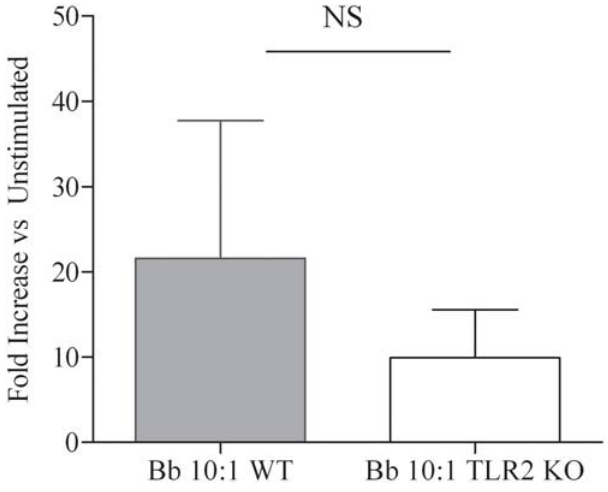
Figure 8. Wild type (WT) and TLR2 deficient bone marrow derived macrophages (BMDMs) generate similar IFN- b re- sponses to Bb. WT or TLR2 2 / 2 mouse BMDMs were incubated for six hours with Bb (MOI 10:1). Fold increase in IFN- b transcript copies measured from Bb stimulated BMDMs are compared to control values from unstimulated cells. Bars depict the means + / 2 standard error of the mean. Values were not statistically significantly different.